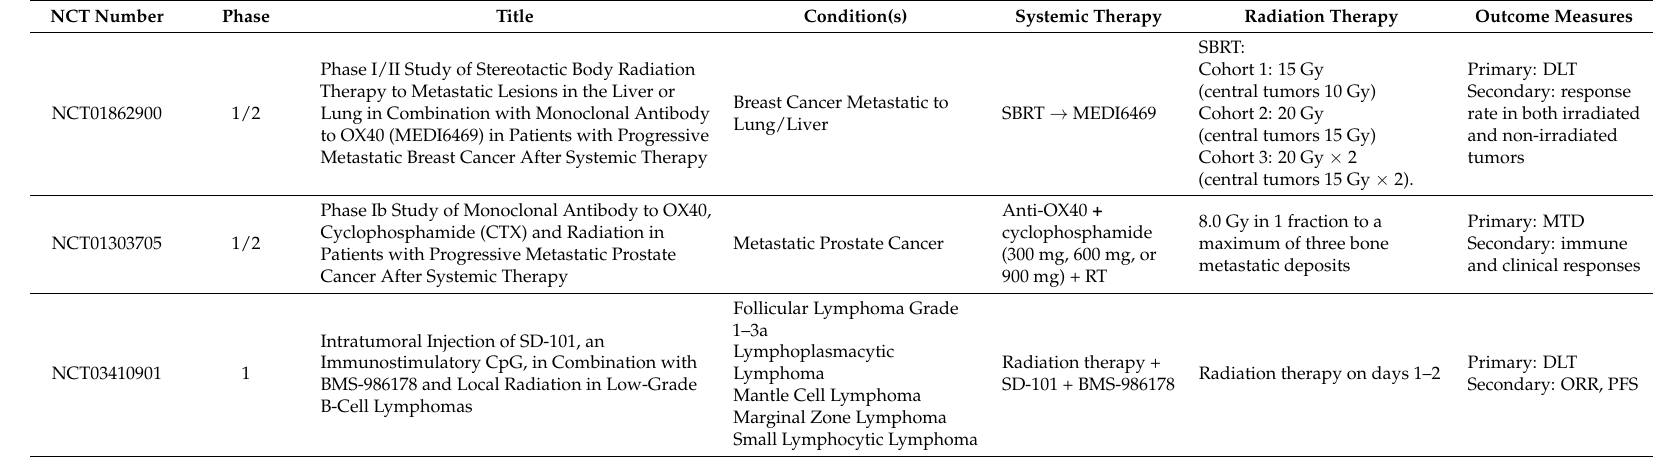
Table 3. Active Clinical Trials Combining OX40 Stimulation with